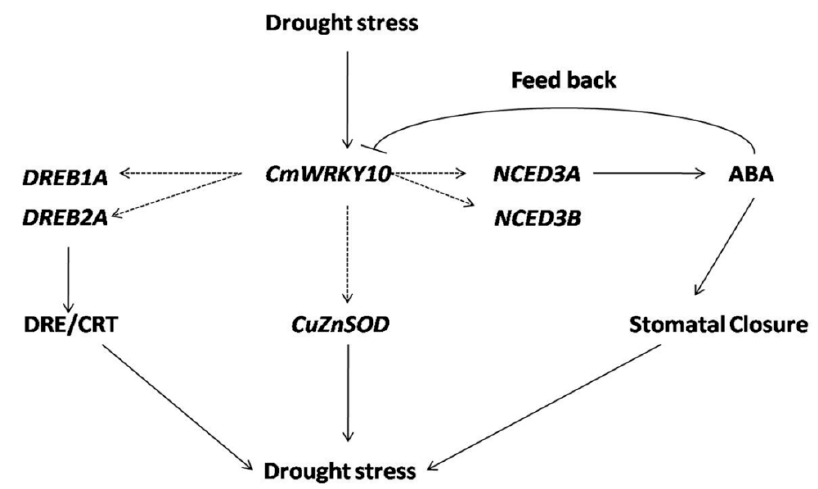
Figure 7. A model of the interaction between CmWRKY10 and ABA-responsive genes under drought conditions. Solid arrows define the proved interactions while dashed arrows present the proposed interactions based on the results of present study.